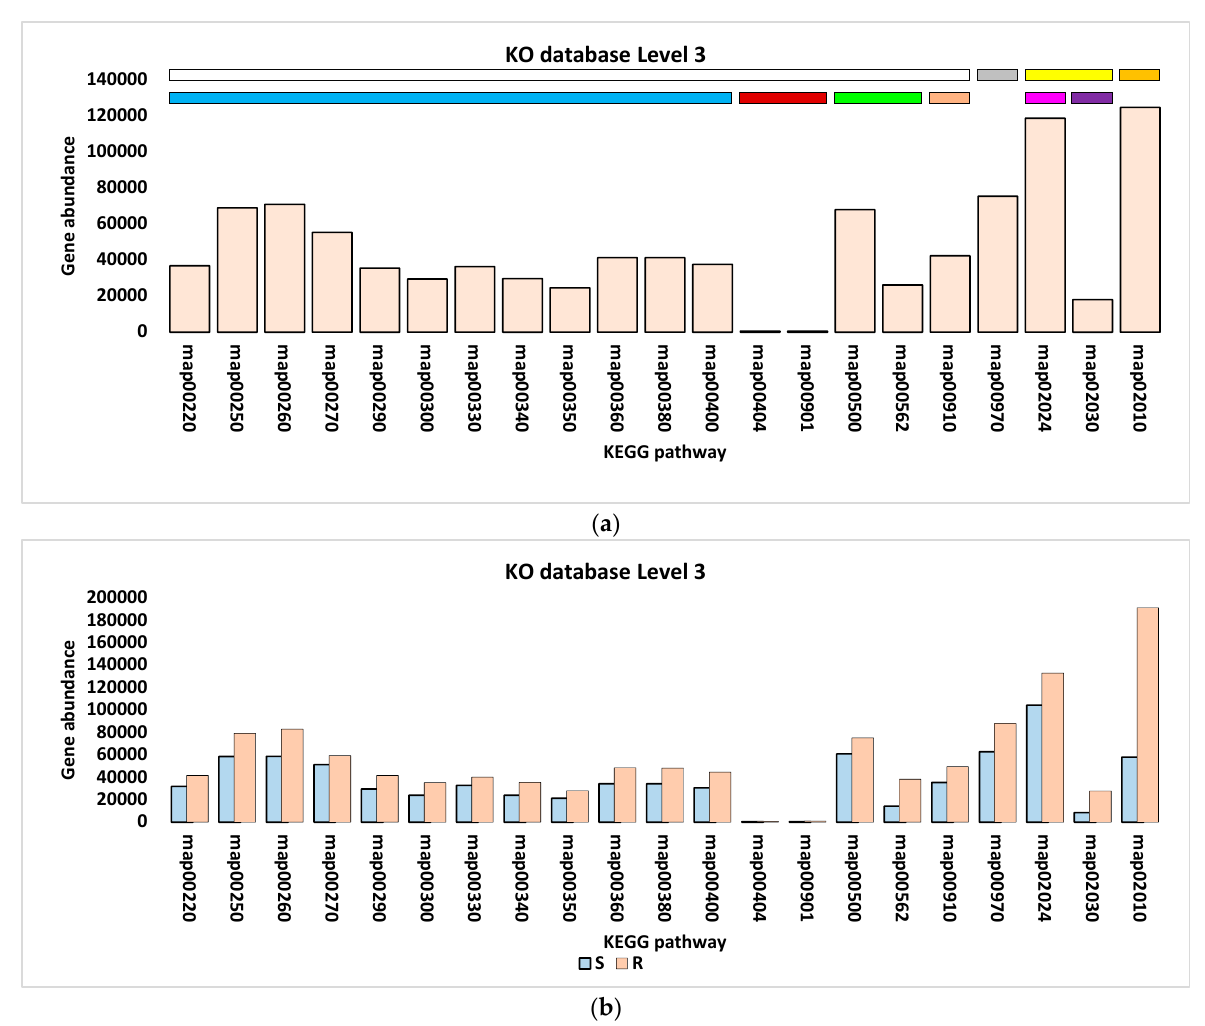
Figure 4. Abundance of genes encoding enzymes of the different functional pathways of KEGG database Level 3 across ( a ) and between ( b ) samples of rhizosphere (R) and surrounding bulk soil (S) microbiomes of M. oleifera . KEGG map IDs refer to KEGG pathway identifiers. The white box in ( a ) indicates pathways of the category “Metabolism”, while gray, yellow and orange boxes indicate pathways of categories “Genetic Information Processing” (sub-category “Translation”), “Cellular Processes”, and “Environmental Information Processing” (sub-category “Membrane transport”), respectively. The sub-categories of “Metabolism” include “Amino acid metabolism” (light blue box), “Biosynthesis of other secondary metabolites” (dark red box), “Carbohydrate metabolism” (light green box), and “Nucleotide metabolism” (light brown box). The sub-categories of “Cellular Processes” include “Quorum sensing” (dark pink box) and “Bacterial chemotaxis” (violet box). The data in ( b ) is further described in Figure S4, while detailed abundance records of ( a ) and ( b ) are shown in Tables S7 and S10,